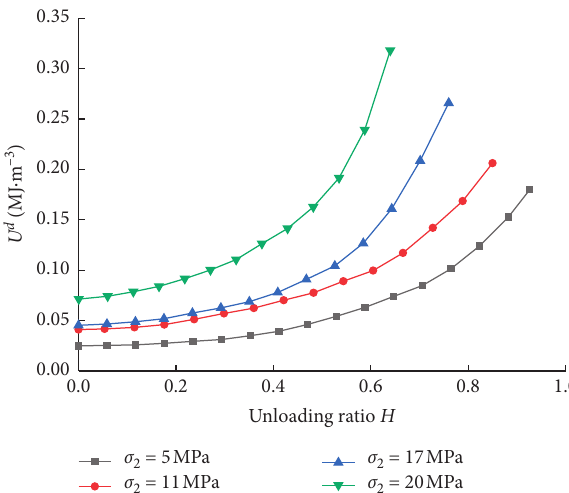
Figure 7: The fitting curves of energy- σ the unloading σ